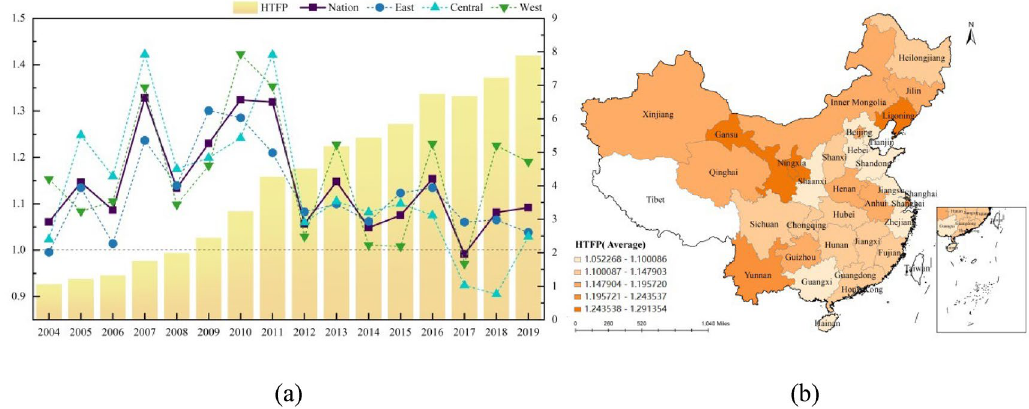
Figure 5. Temporal and spatial characteristics of